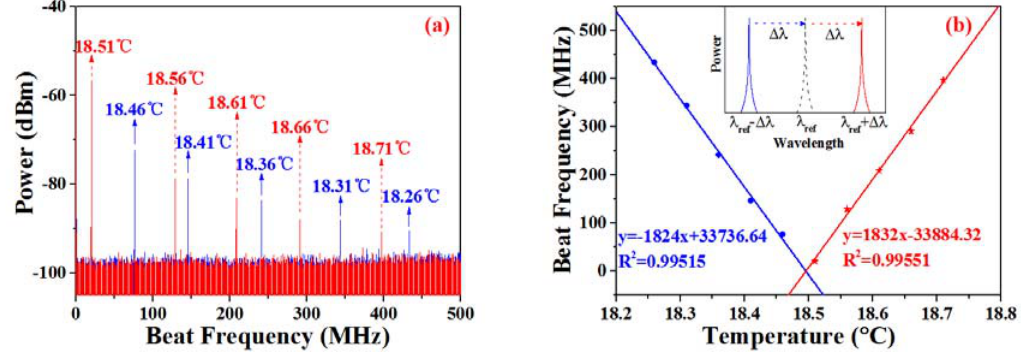
Figure 5. ( a ) Beat frequency spectra with the temperature increased from 18.26 °C to 18.71 °C; ( b ) Relationship between temperature and beat frequency. ( b ) Relationship between temperature and beat